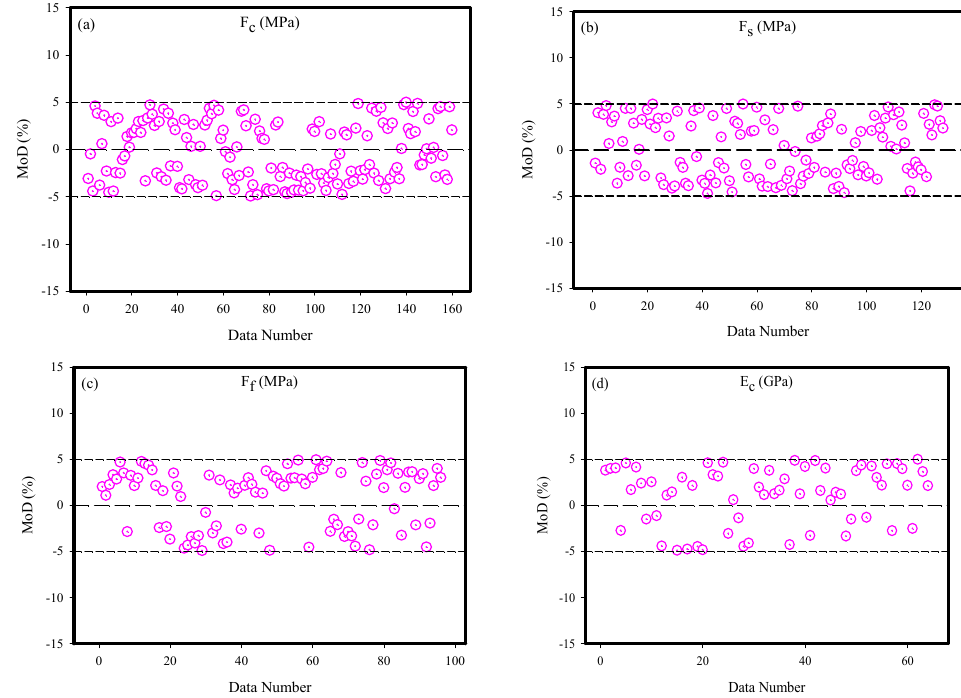
Figure 10. Predictions using ANN and targeting values considering data’s number.